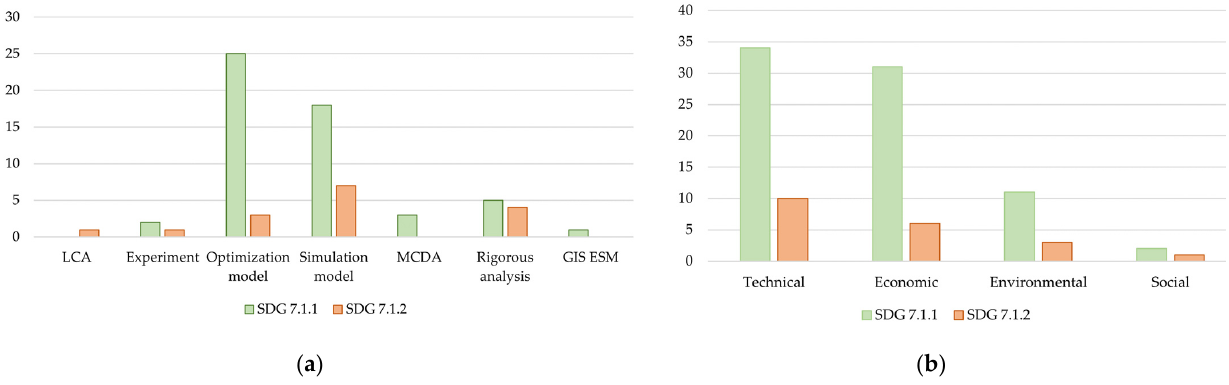
Figure A3. ( a ) Methods applied in studies on SDG 7.1.1 and SDG 7.1.2, and ( b ) Dimensions covered in studies on SDG 7.1.1 and SDG 7.1.2.